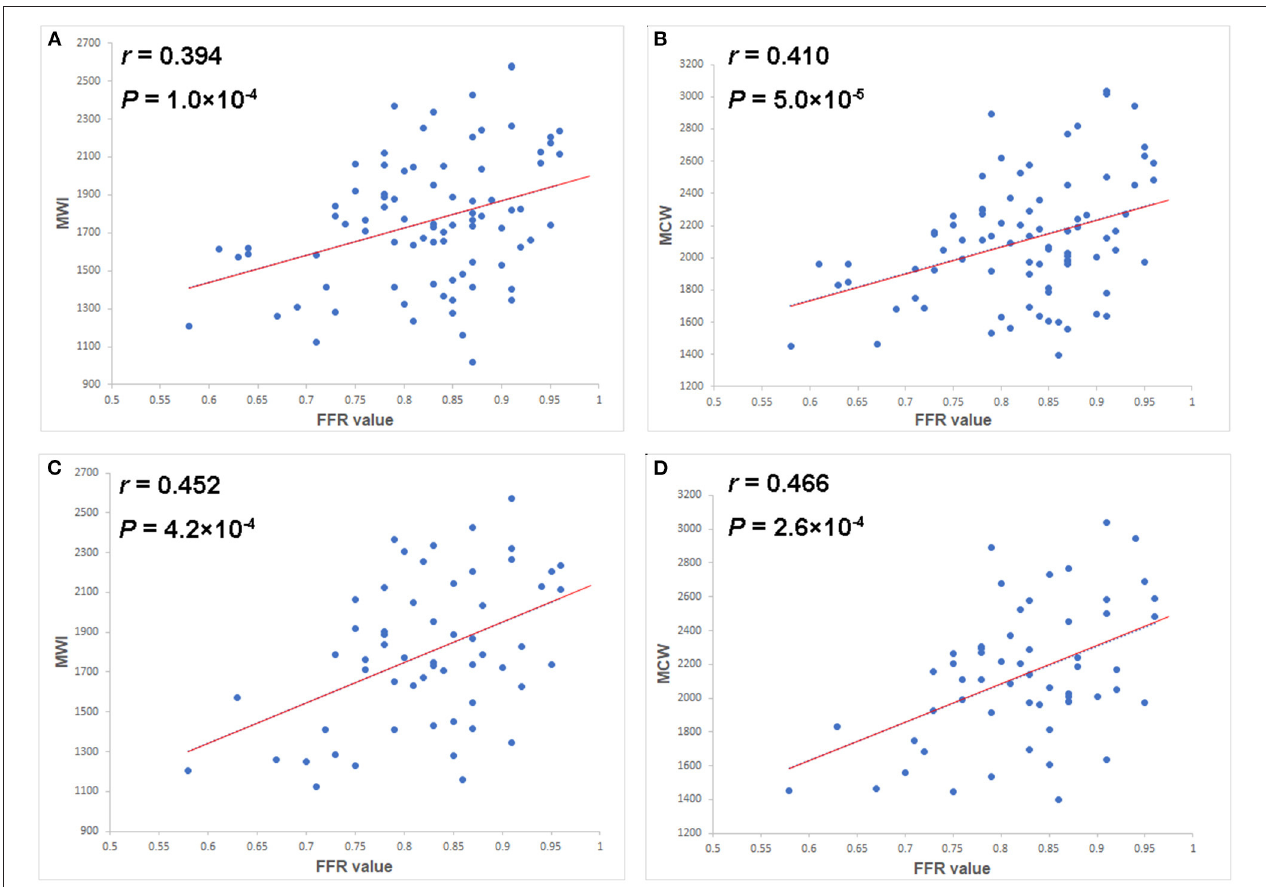
FIGURE 3 | Scatter plots of the MWI (A) and MCW (B) in the total-vessel stenosis group, and of the MWI (C) and MCW (D) in the single-vessel stenosis subgroup vs. FFR values. Both MWI and MCW showed mild but significant positive correlations with FFR values ( r = 0.394 , p = 0.000 and r = 0.410, p = 0.000 in total group; r = 0.452, p = 0.000 and r = 0.466, p = 0.000 in single vessel group). FFR, fractional flow reserve; MCW, myocardial constructive work; MWI, myocardial work index.